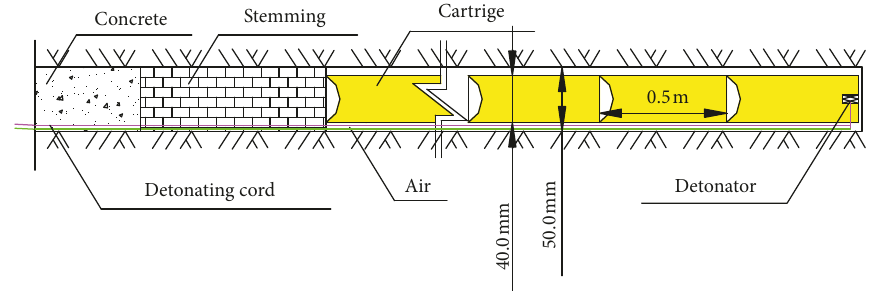
Figure 16: Schematic of the charge structure.